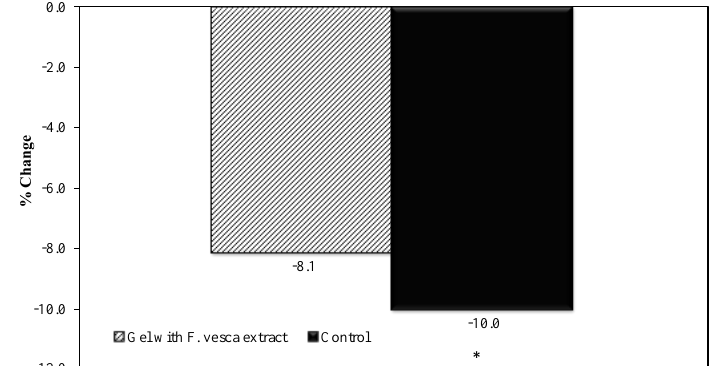
Figure 4. The b* parameter evolution before and after UVA irradiation (Mean ± SD, n = 21). Moreover, the statistical comparison against D0 is shown (* p < 0.05).